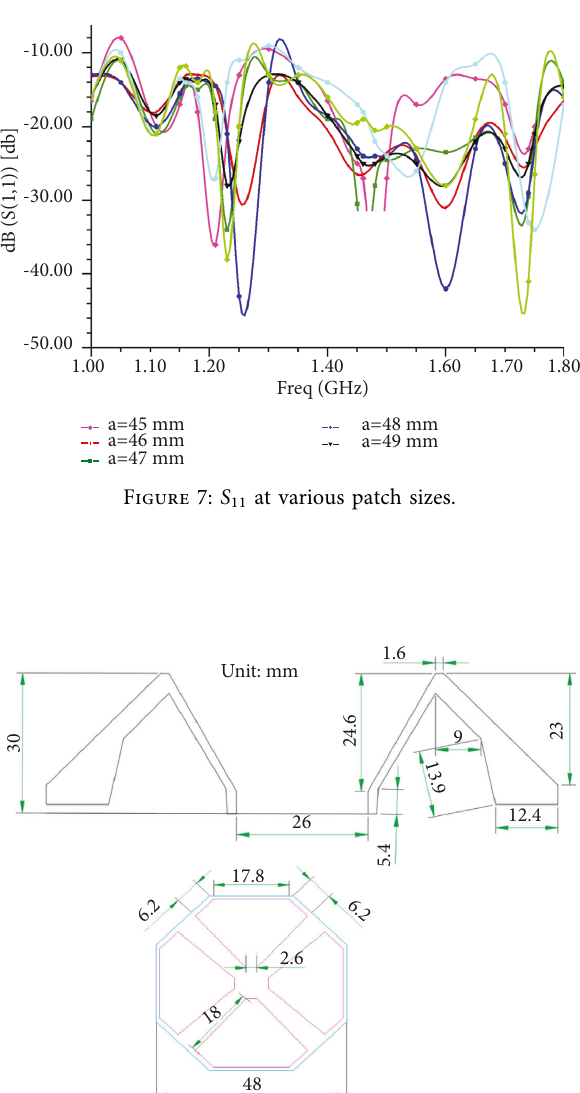
Figure 8: Detailed dimensions of the dipole and patch (unit: mm).